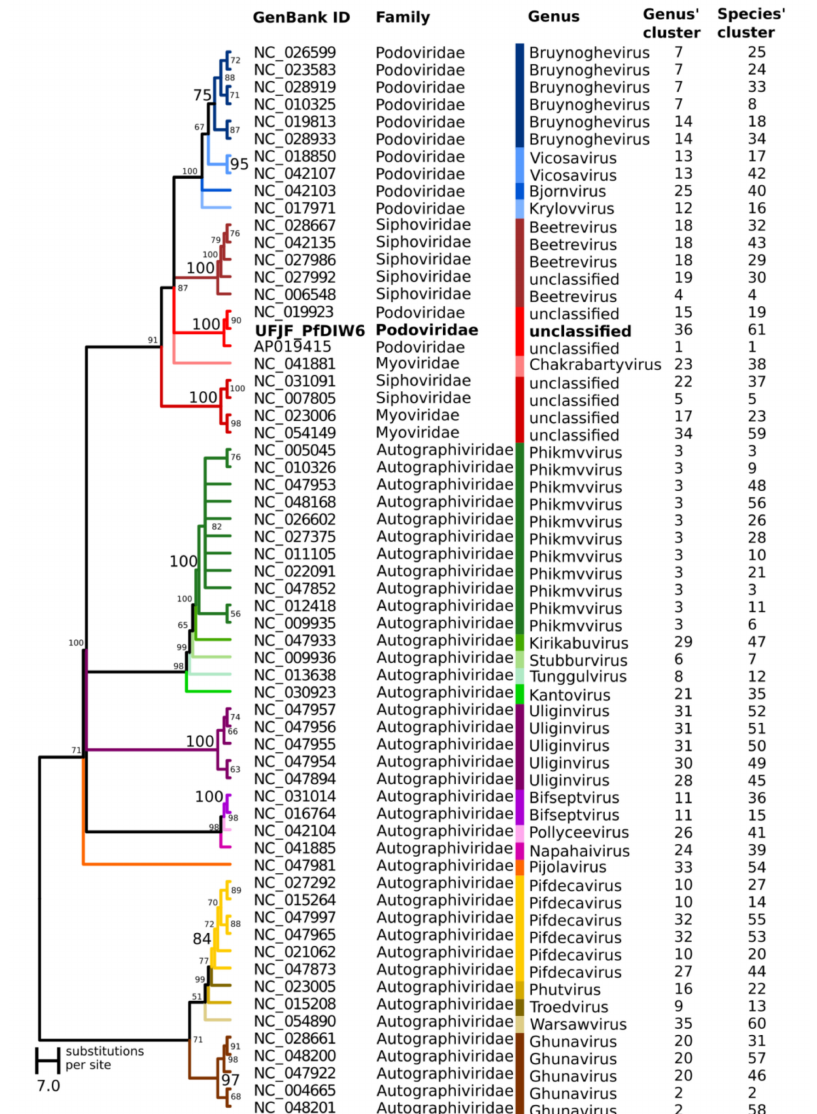
Figure 2. Maximum likelihood tree of the large terminase subunit of phages infecting the genus Pseudomonas . The midpoint rooted maximum likelihood (ML) tree was obtained by analysing terminase large subunit (TerL) amino acid sequences from UFJF_PfDIW6 and other Pseudomonas phages available at NCBI RefSeq database. The bootstrap values (expressed as percentages) calculated from 1000 replicates are shown beside each node. The monophyletic clades corresponding to each genus are shown in different colours. The genomes of Pseudomonas phages were clustered by VIRIDIC using the genomic similarity threshold of 70% for genus assignment (Genus’ cluster) and 95% for species assignment (Species’